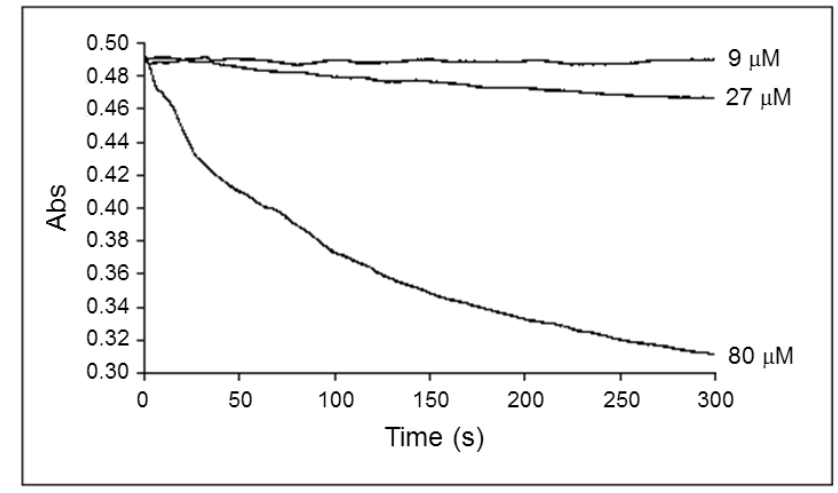
Figure 7. Swelling of isolated rat heart mitochondria respiring on palmitoyl- L -carnitine (9–80 µM) and malate (0.24 mM). n = 3, typical absorption traces are shown.